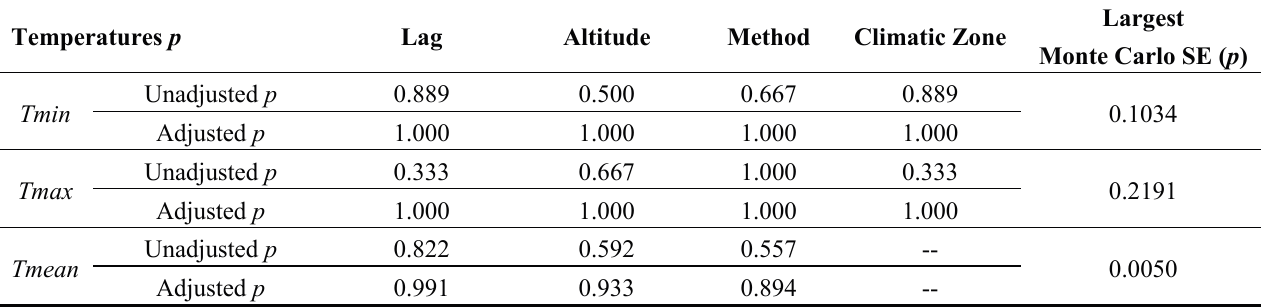
Table 2. Meta regression analysis on the factors and OR of